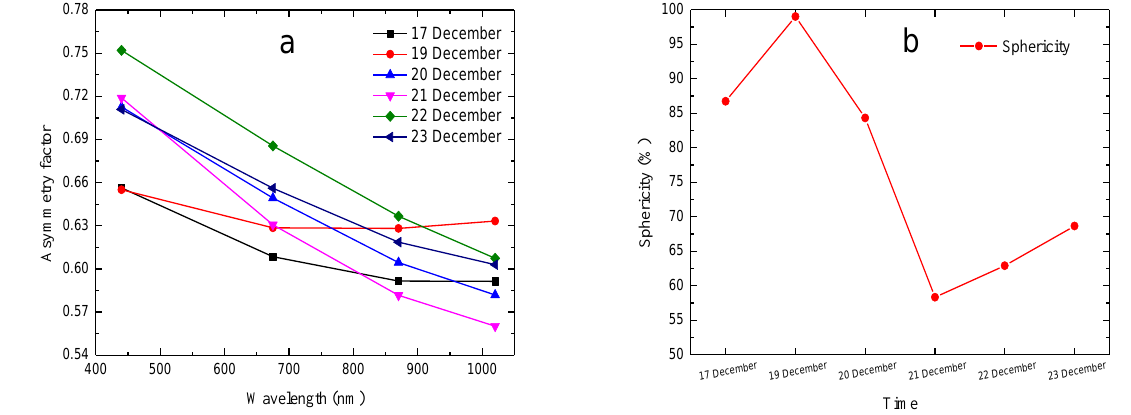
Figure 10. The ( a ) daily averages of asymmetry factor at 440, 675, 870 and 1020 nm; and ( b ) sphericity measurements, in Beijing on 17–23 December 2015.